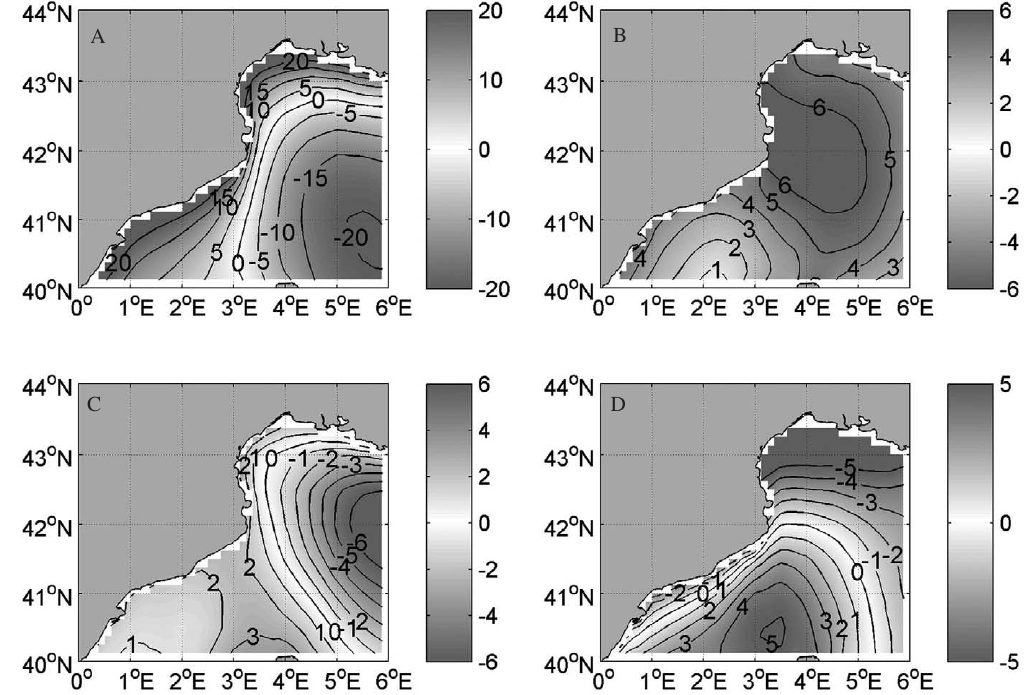
Fig . 7. – a, first spatial variance eof mode for the 95 th percentile sWH; B, second spatial variance eof mode for the 95 th percentile sWH; C, third spatial variance eof mode for the 95 th percentile sWH; and d, fourth spatial variance eof mode for the 95 th percentile